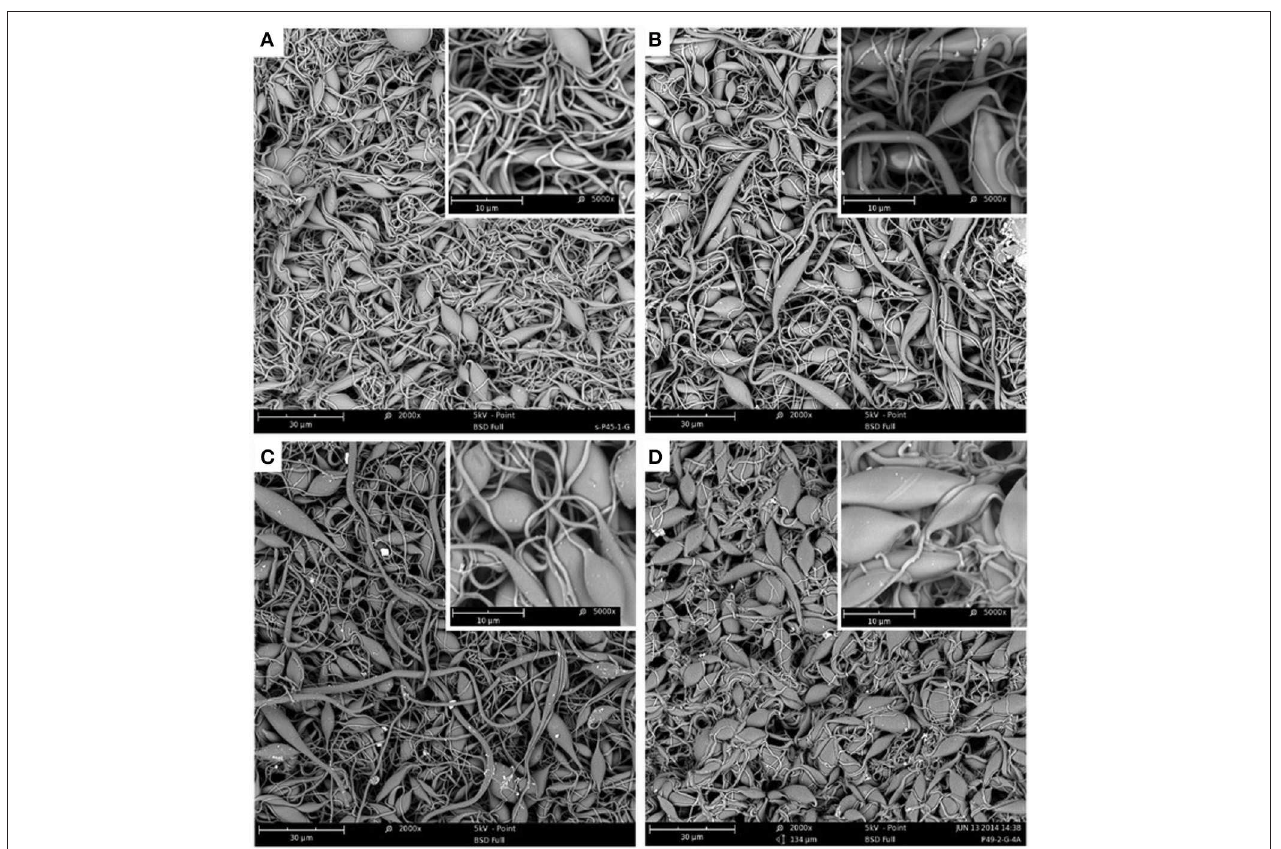
FIGURE 4 | SEM images of 300% poly(GMA)-grafted nanofibers (A) and nanofibers aminated with TEA with DA of 22% (B) , 50% (C), and 82% (D) with magnification of 2,000 and 5,000 (inset).